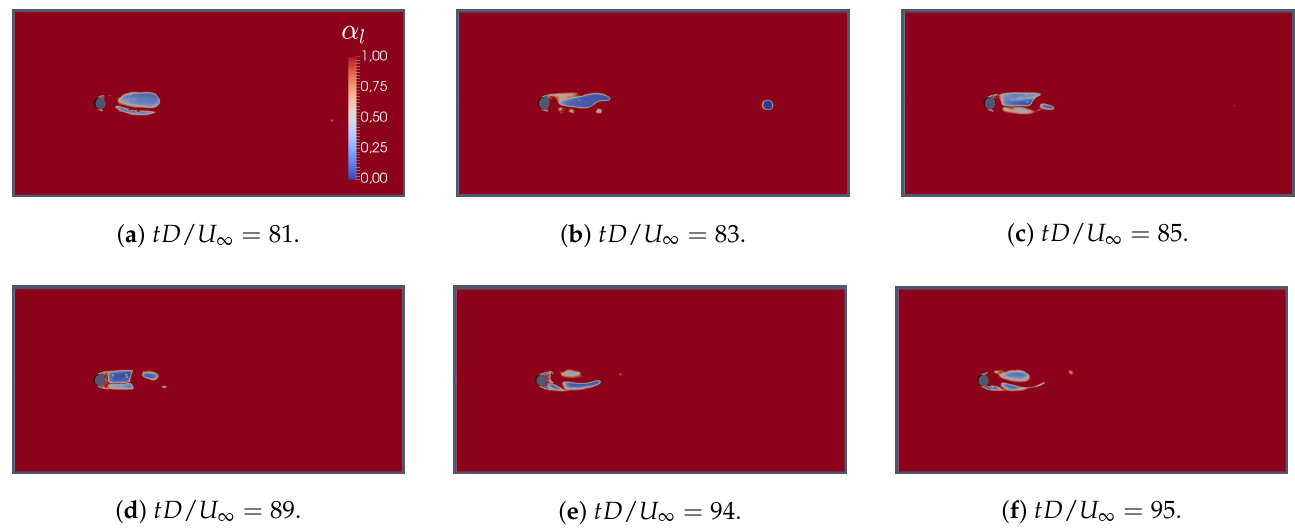
Figure 6. Contour plot of instantaneous liquid fraction, results obtained with Merkle model and considering standard